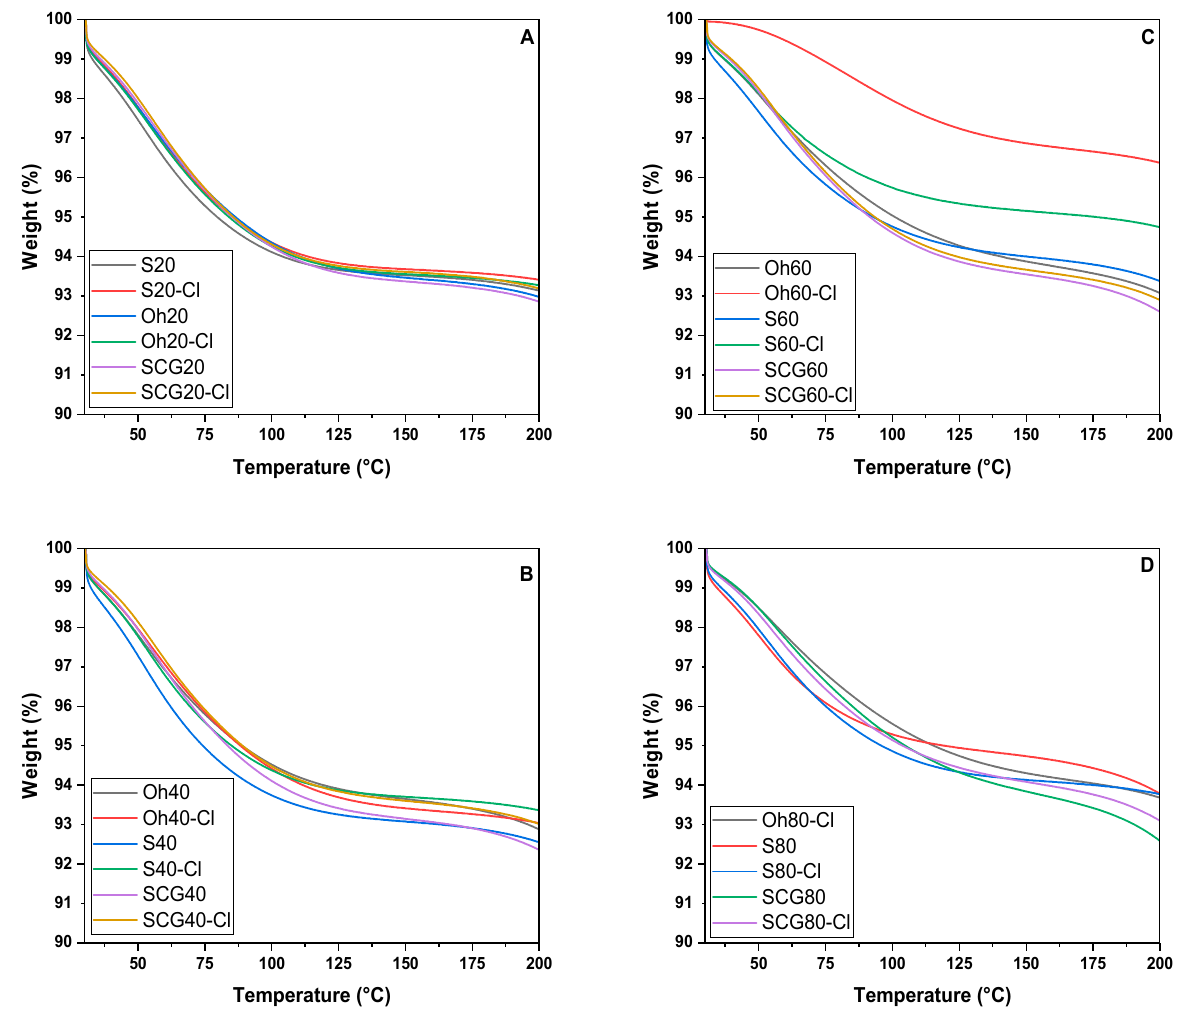
Figure 6. Estimation of water content of dried composites through TGA decomposition profiles, where each panel (A-D) describes composites with variable biomass content: ( A ) 20 wt.%, ( B ) 40 wt.%, ( C ) 60 wt. % and ( D ) 80 wt.%.